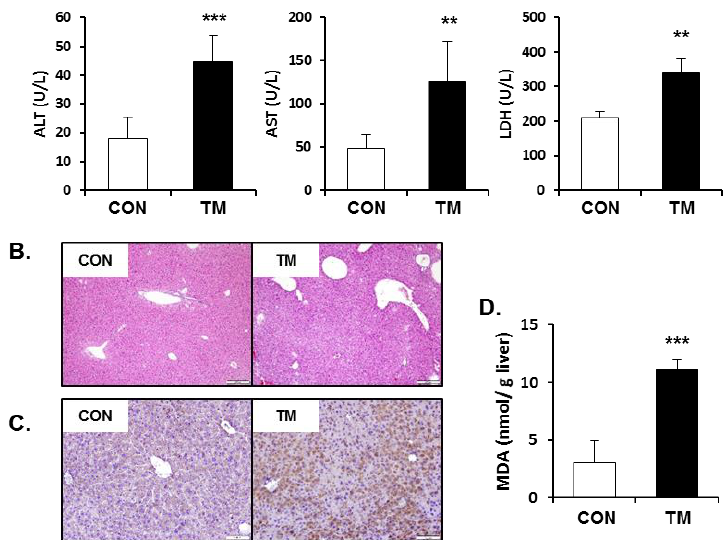
Figure 3. Increased hepatotoxicity accompanied with oxidative stress by tunicamycin (TM) treatment. ( A ) Serum activities of alanine aminotransferase (ALT), aspartate aminotransferase